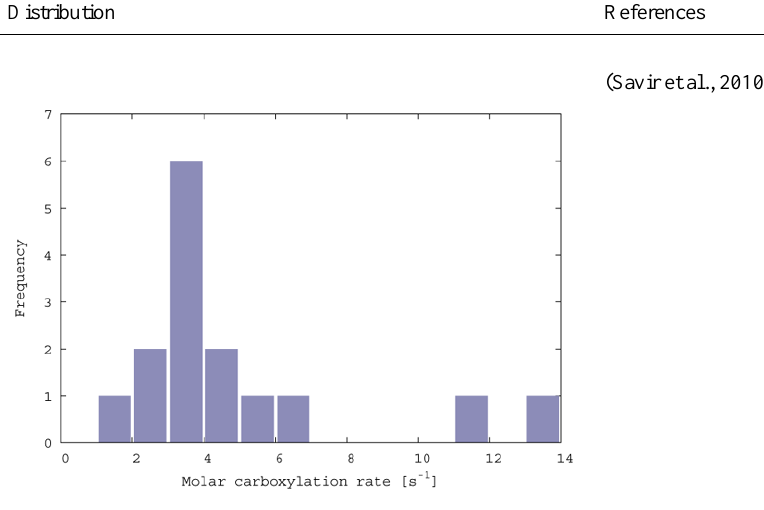
Fig. B4. Overview of the distribution of the molar carboxylation rate of